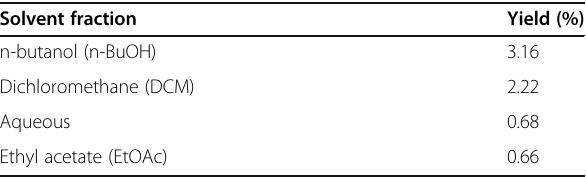
Table 1 Percentage yield of different solvent fractions of 80% methanol extract of P. guineense Solvent fraction Yield (%) n-butanol (n-BuOH) 3.16 Dichloromethane (DCM) 2.22 Aqueous 0.68 Ethyl acetate